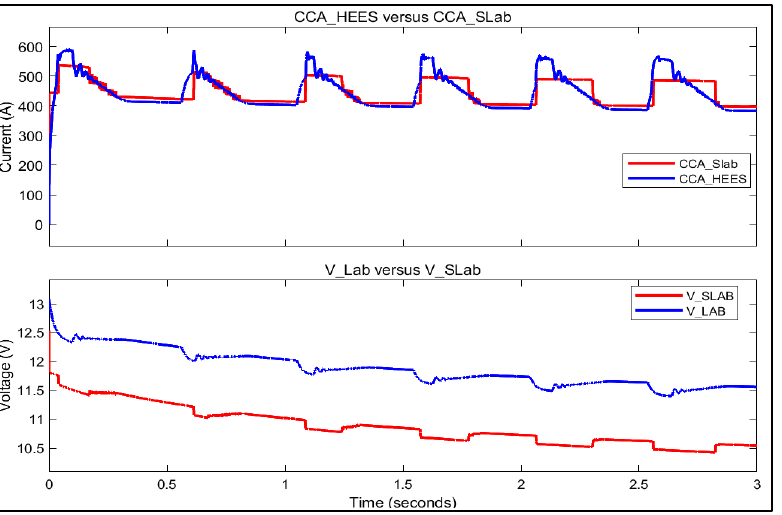
Figure 14. The delivered HESS CCC versus SLAB and voltage response of LAB versus SLAB during discharging modes for case two.